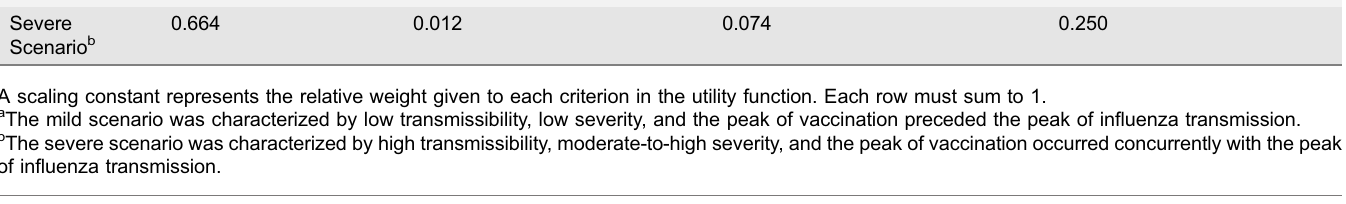
Table 2 lists their averaged probabilities.